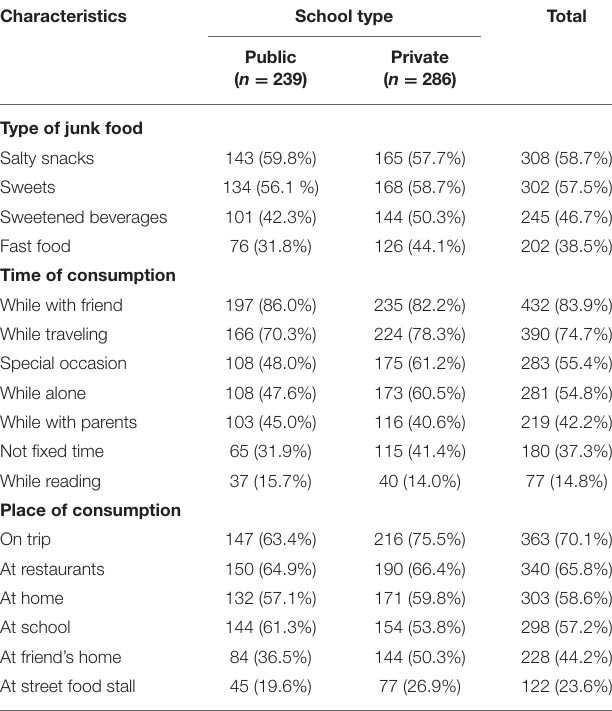
TABLE 4 | Average consumption of type of junk food in last month ( n = 525).